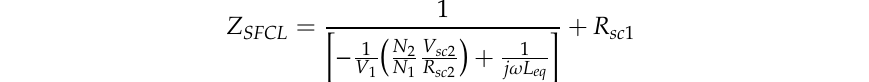
Table 1. Specifications of bridge type SFCL with simultaneous quench using flux-coupling. HTSC = high-temperature superconductor.